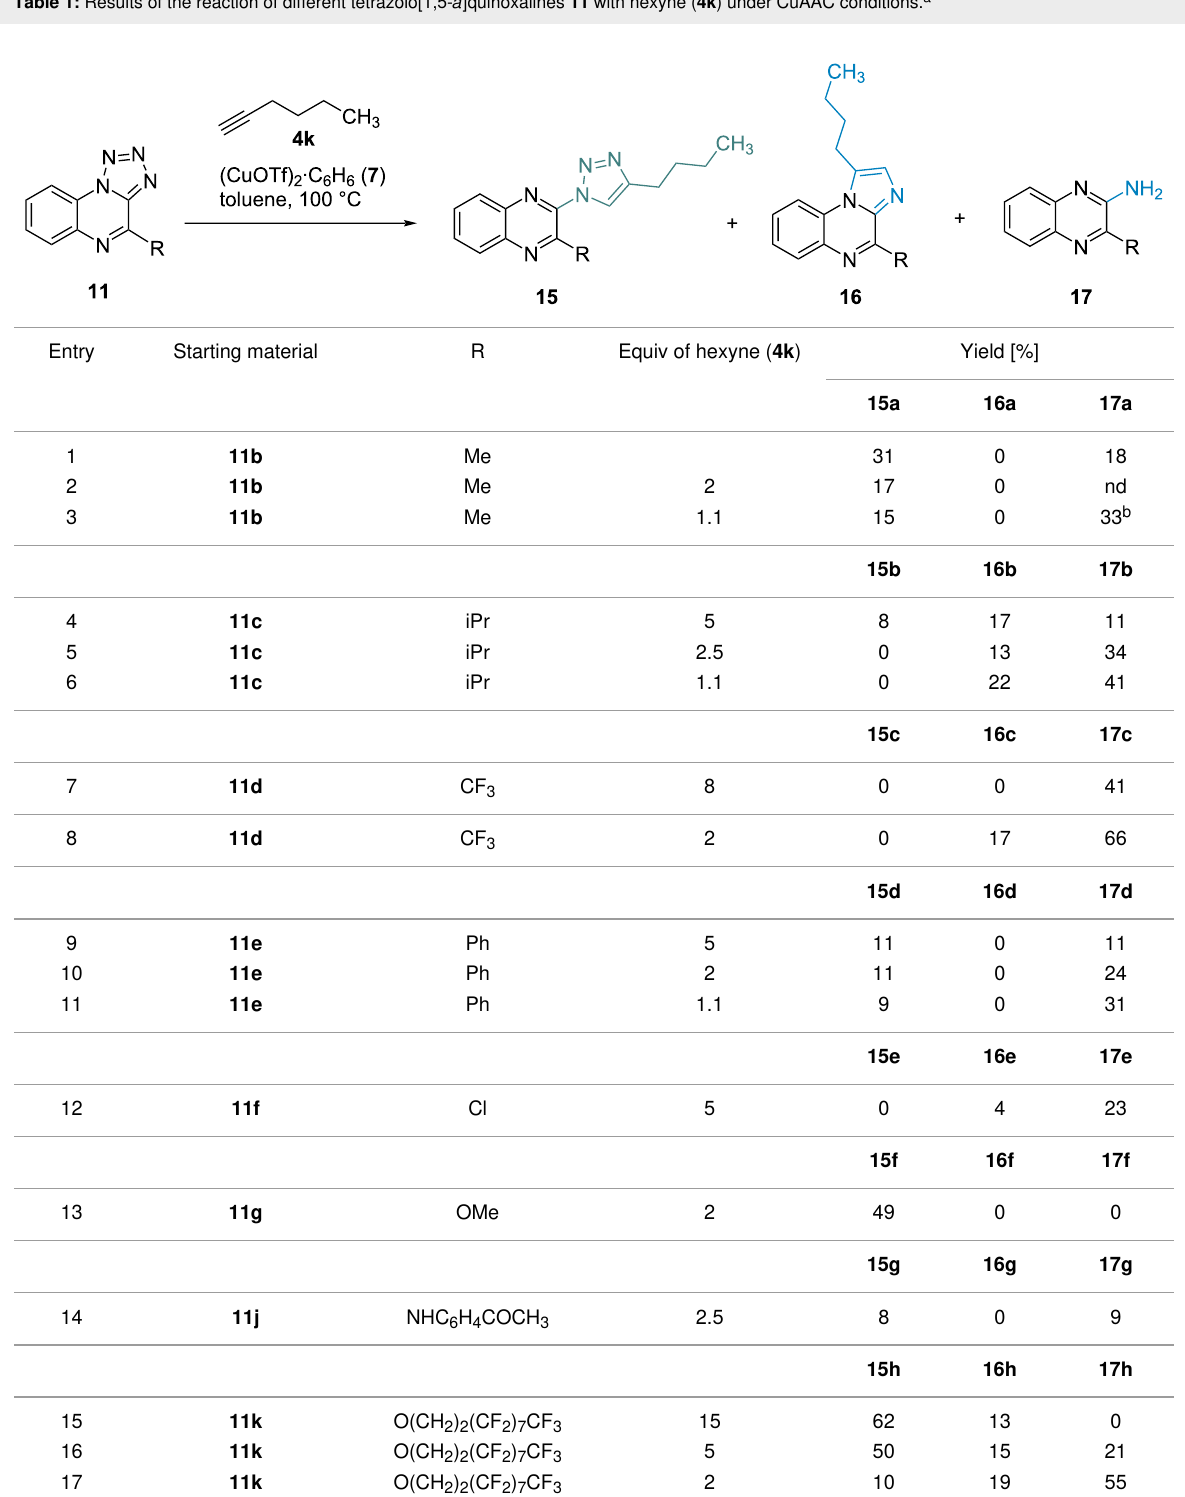
Table 1: Results of the reaction of different tetrazolo[1,5- a ]quinoxalines 11 with hexyne ( 4k ) under CuAAC conditions.